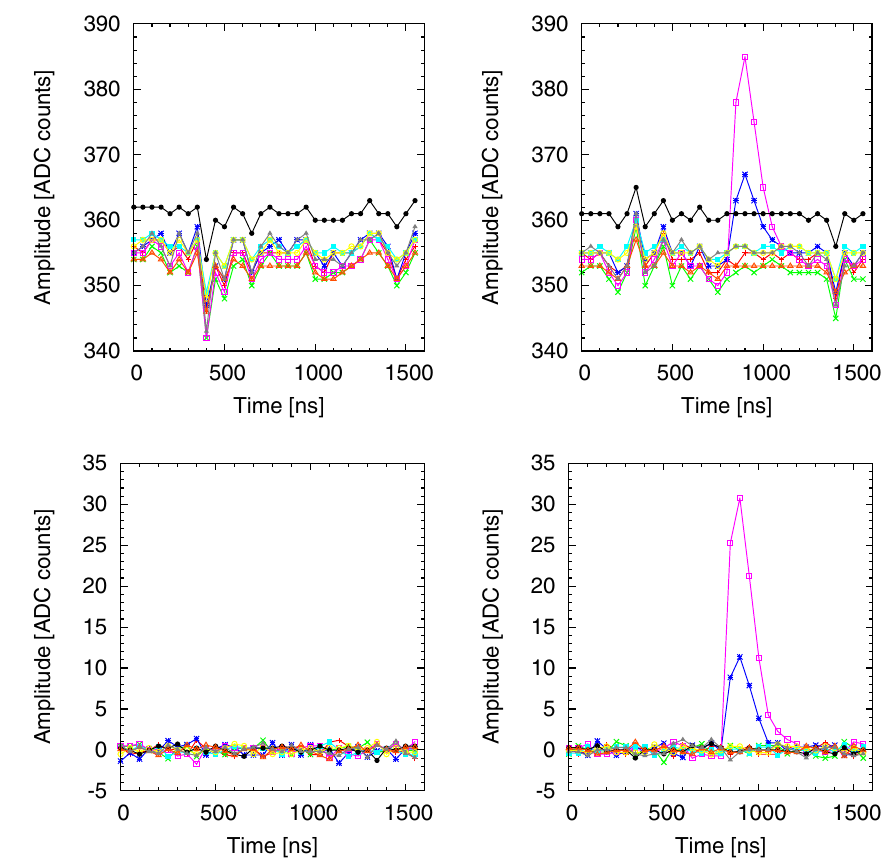
containing electrons and muons, obtained as the sum of all 128 channels in the stack for each event. The narrow